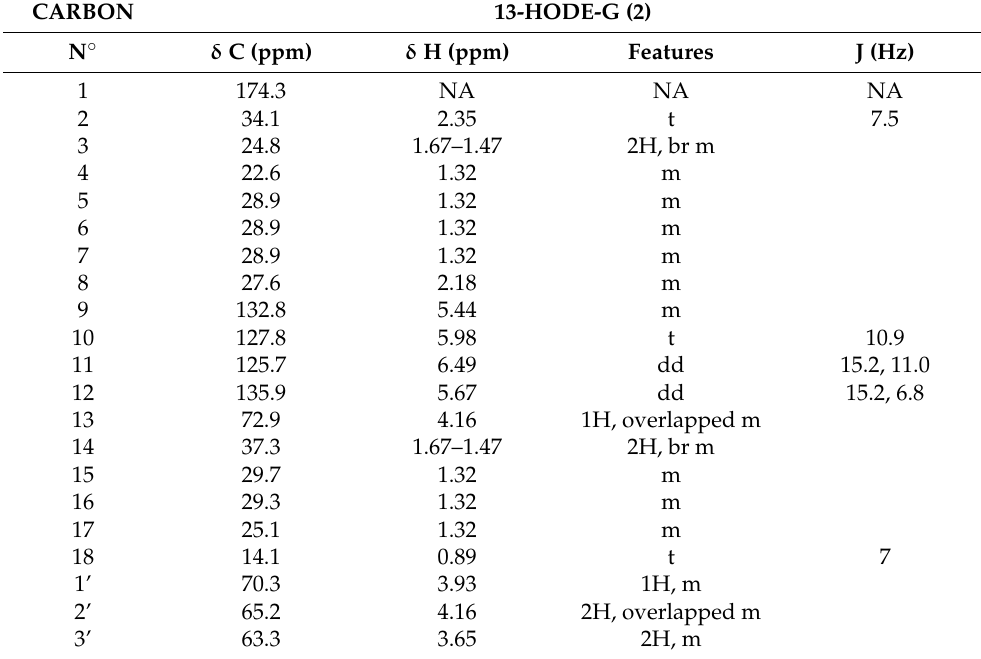
Table 2. 1 H-NMR and 13 C-NMR data of